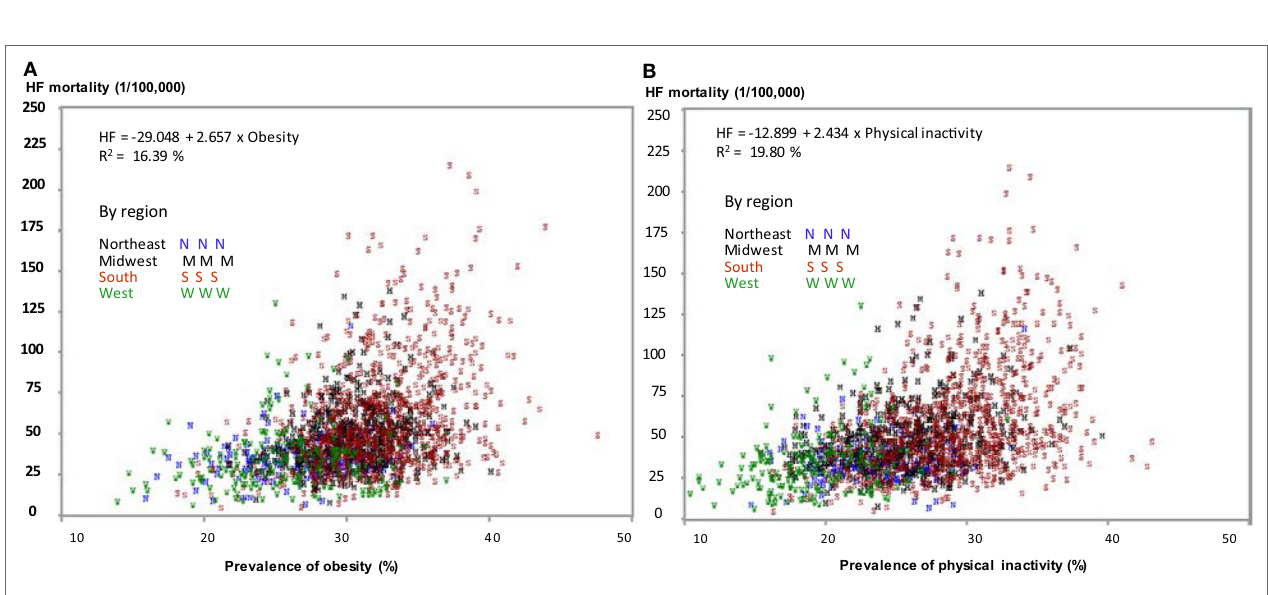
FigUre 4 | Correlation of age-adjusted prevalence of high blood pressure (HBP) (a) and diabetes (B) with age-adjusted heart failure (HF) mortality in 1,724 counties by regions.